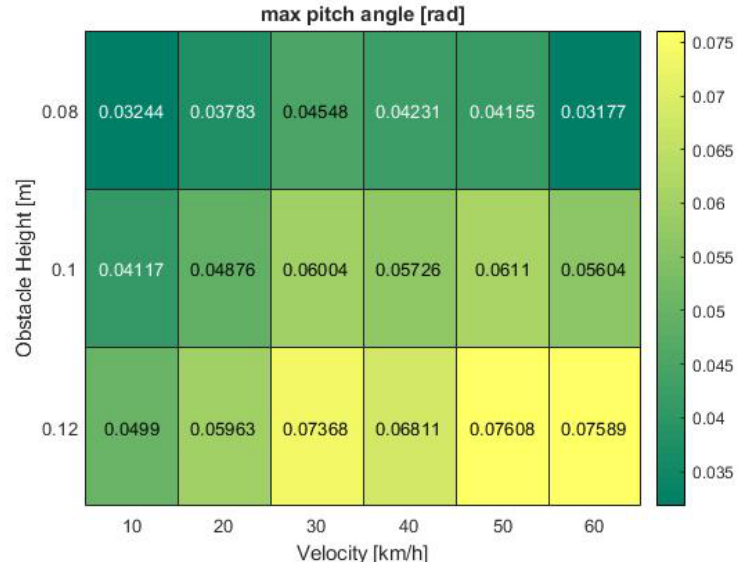
Figure 12. Pitch angle at various bump obstacle heights and vehicle velocities in the